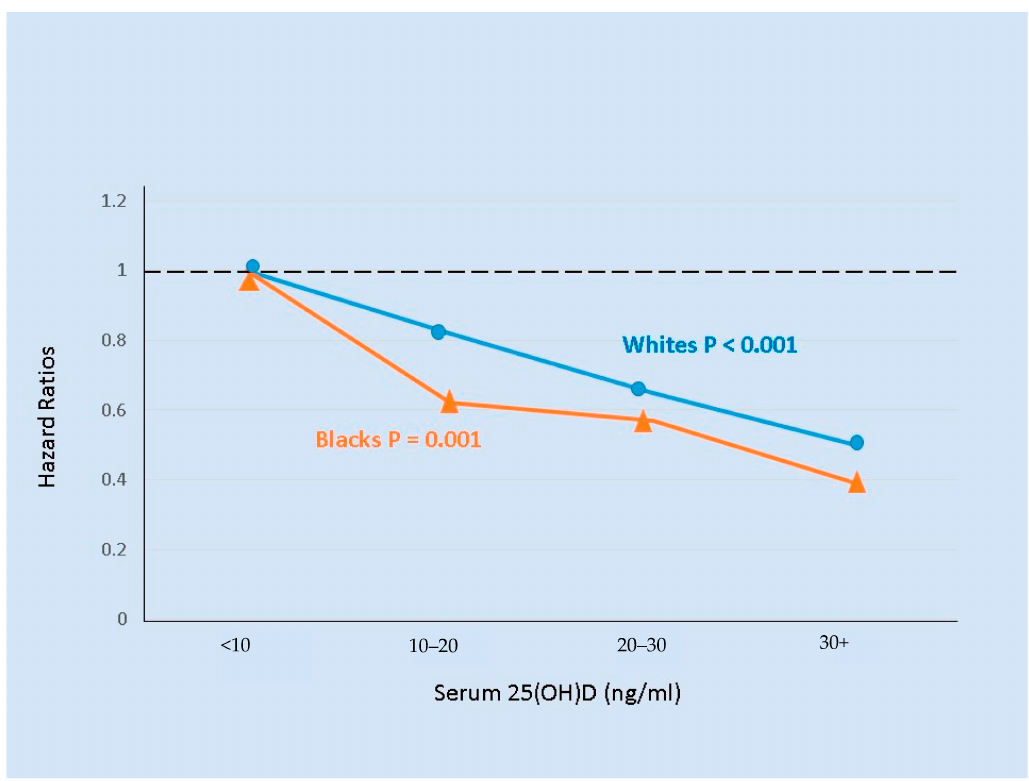
Figure 4. Serum 25(OH)D levels and all-cause mortality for elderly Black ( n = 1023) and White ( n = 1615) men and women followed for up to 8.5 years [159]. Hazard ratios with < 10 ng/mL serum 25(OH)D as the reference were adjusted for other predictors of mortality.